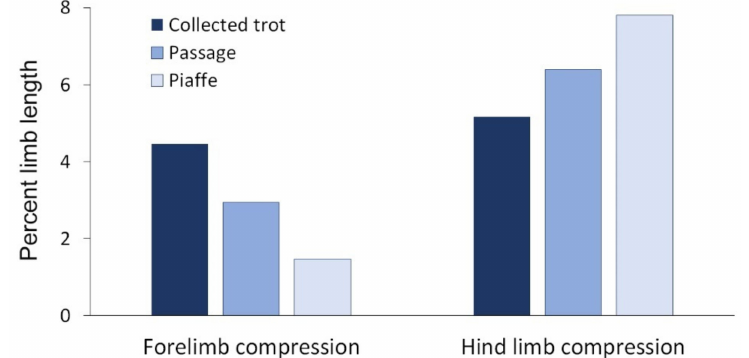
Figure 8. Forelimb and hind limb maximum vertical compression relative to standing height during the stance phase in collected trot, passage and pia ff